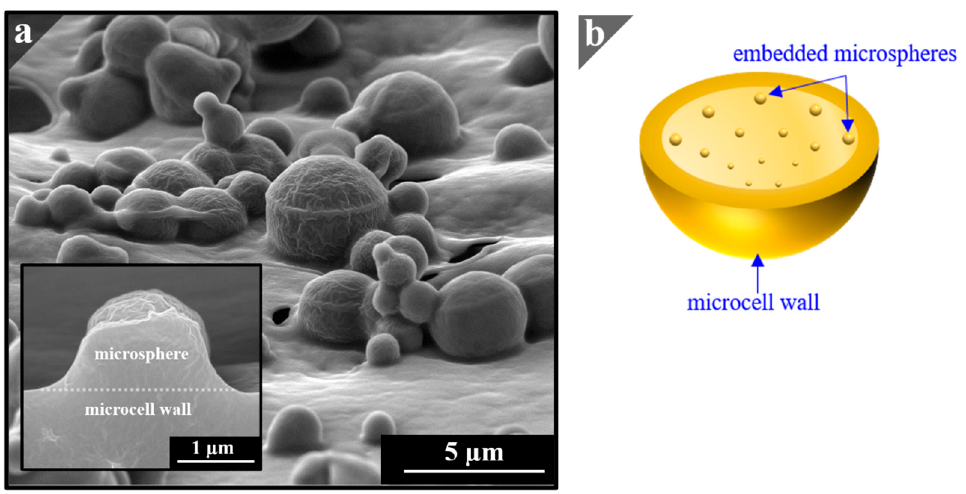
Figure 5. ( a ) High magnification SEM micrographs of the reinforcing microspheres on the cell walls of cured foam sample, and ( b ) a schematic representation of a microsphere-reinforced microcell. As can be seen from the inset, the cross-section confirms that the microspheres are dense.